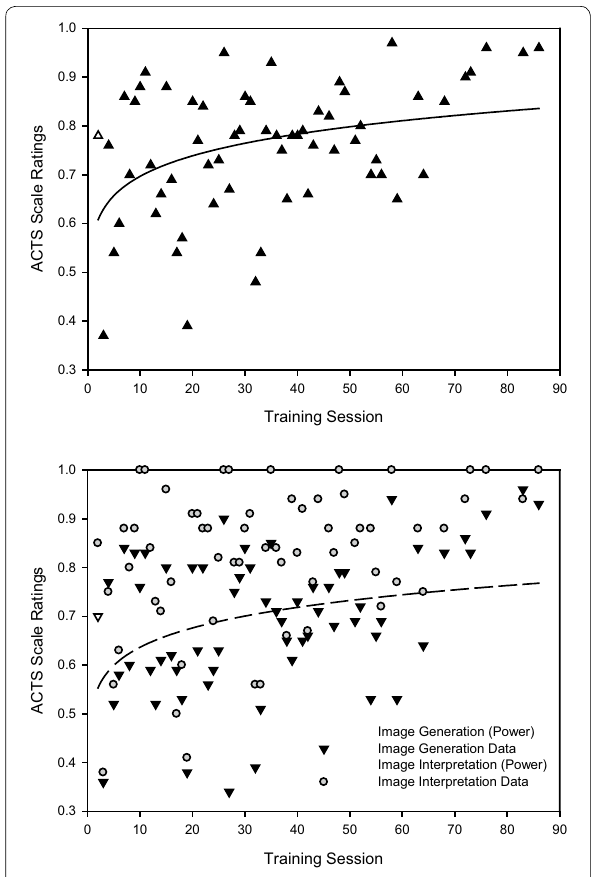
Fig. 3 Learning curves for mean overall performance across ACTS subscales (top) and Image Generation and Image Interpretation subscales (bottom). Best-fit power functions are plotted in